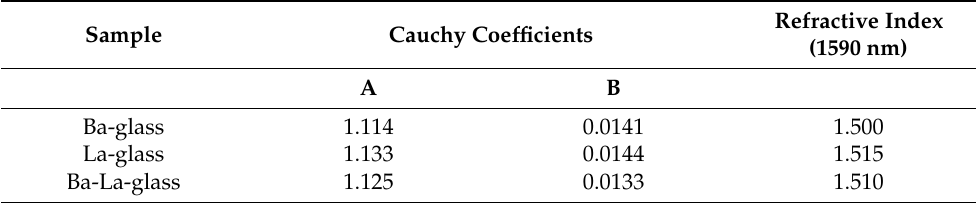
Table 2. Cauchy coefficients of the samples before laser processing and index values at 1590